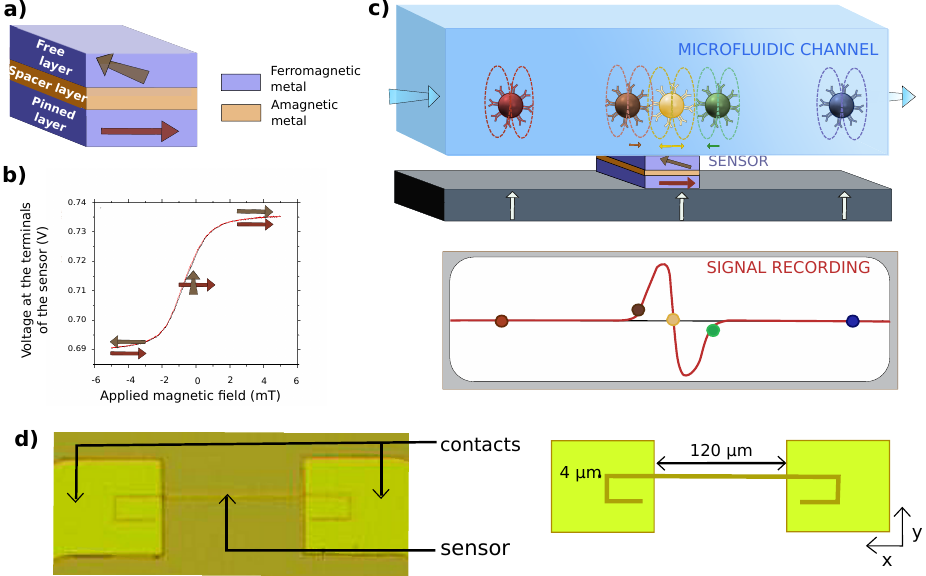
Figure 3. Giant magnetoresistance (GMR) sensor. ( a ) Scheme of the main components of a GMR stack. Free and pinned layers are ferromagnetic and their magnetization are represented by arrows. The spacer is a diamagnetic conductor. ( b ) Experimental sensitivity curve with schematic representation of the relative orientations of the two ferromagnetic layers. This sensor shows a sensitivity of 2 %.mT − 1 and no hysteresis on its linear portion. ( c ) Schematic of the experiment: Labeled objects are moved by the laminar flow at a given height crossing the sensor at constant speed. The sensor detects variations of the magnetic field due to the induced dipolar field of the beads. The beads are magnetized by a field normal to the sensor plane created by a permanent magnet. ( d ) Photograph and scheme of a processed GMR sensor in yoke shape. The sensor measures 120 µ m along the x axis and 4 µ m along the y